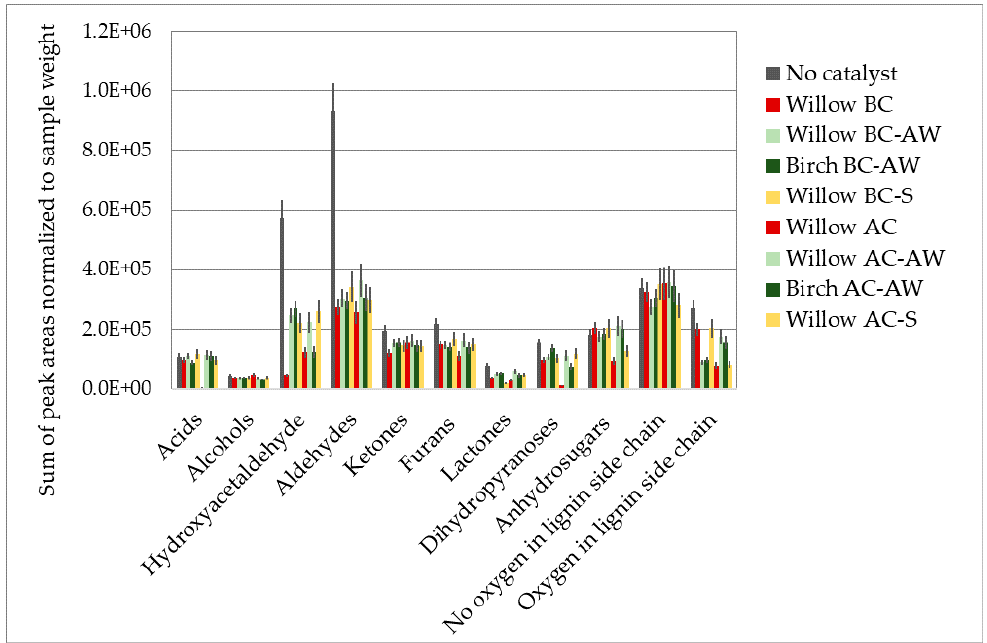
Figure 2. Polysaccharide and lignin pyrolysis derivatives from pine wood with and without catalytic post-treatment determined by gas chromatography with flame ionization (GC-FID). BC = biochar, AW = acid washed, S = sulfonated, AC = activated carbon.